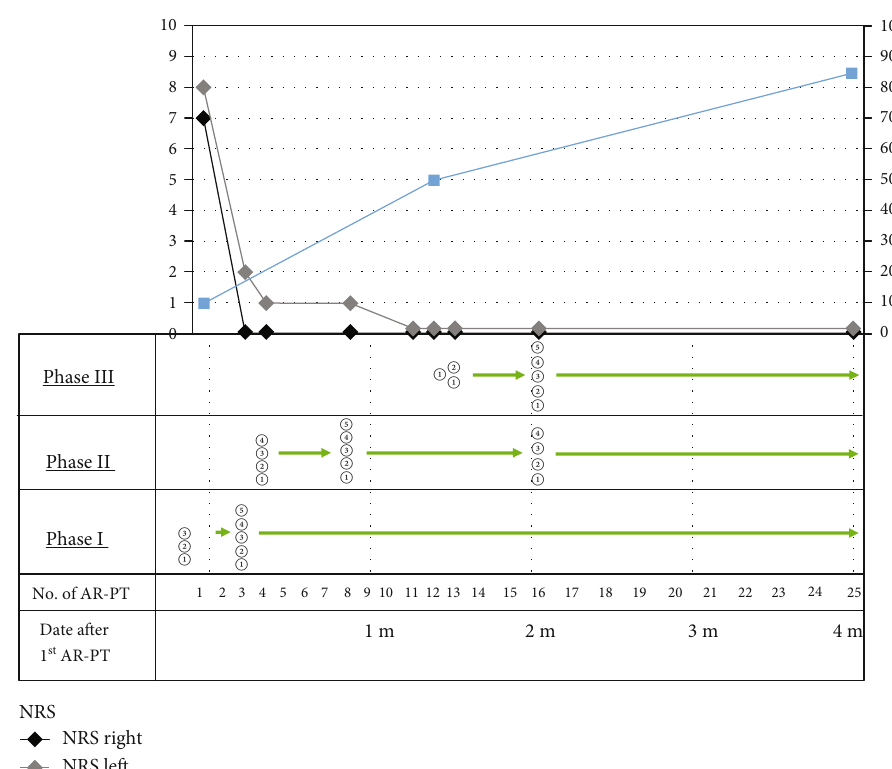
Figure 4: The program of athletic rehabilitation-based physical therapy (AR-PT) for the present patient and the change of her symptoms. Programs applied for this patient are shown. The circled numbers at phase I, phase II, and phase III are the programs described in Figure 3. NRS: Numerical Rating Scale; JOA-CMEQ: Japanese Orthopaedic Association-Cervical Myelopathy Evaluation Questionnaire; m: